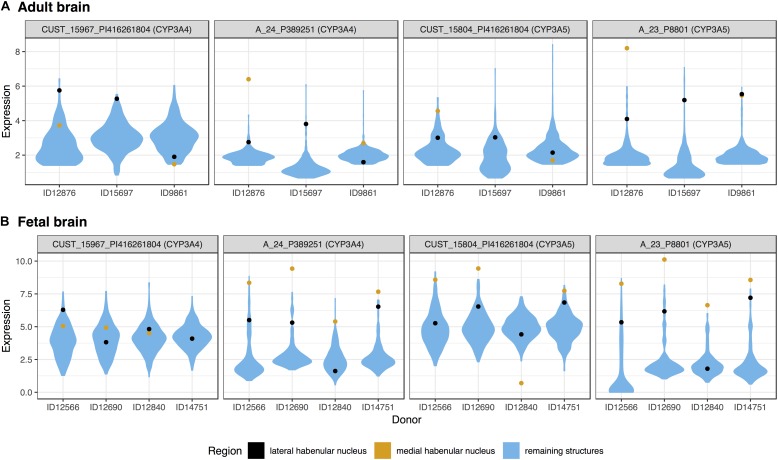
Violin plots of CYP3A4 and CYP3A5 expression in the adult (A) and fetal (B) brains. Expression (log2 intensity) is plotted individually for each probe on the y-axis (gene symbols in parenthesis). Donor identification numbers are marked in the x-axis. Expression in the lateral habenula is marked in black with orange marking the medial division. The distribution of expression across the remaining brain regions is shown in blue.